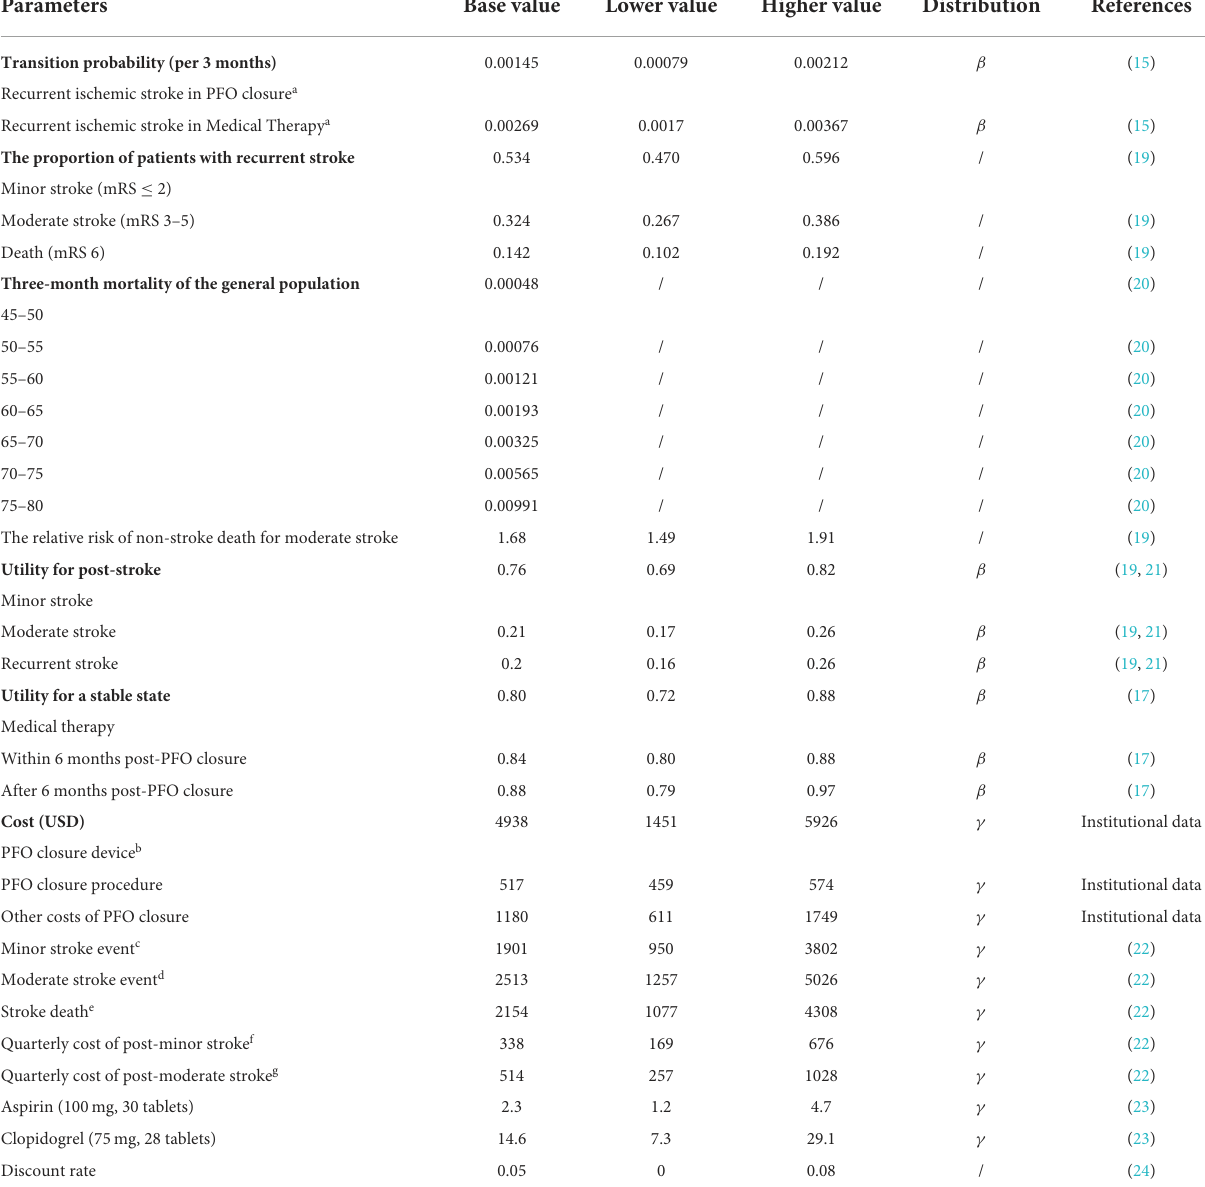
TABLE 1 Input parameters of transition probability, utility, and cost in the base case